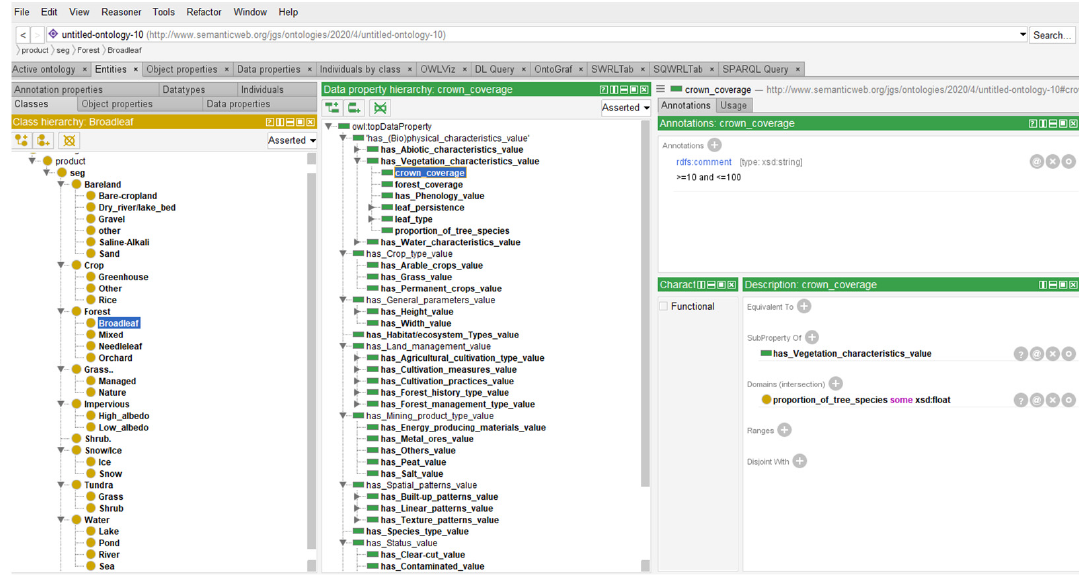
Figure 6. FROM-GLC-Seg land-cover ontology.